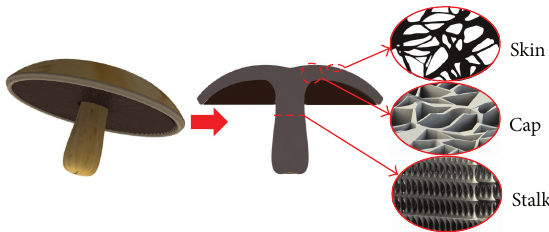
Figure 1: Schematic representation of the PM specimen, the sectioning process, and the modelled architecture of CST, CT, and ST,